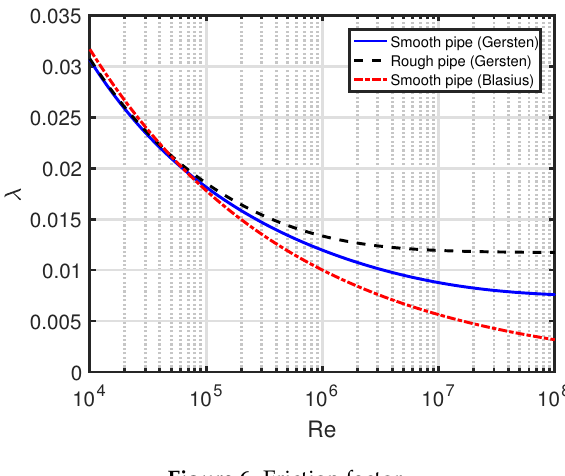
Figure 6. Friction